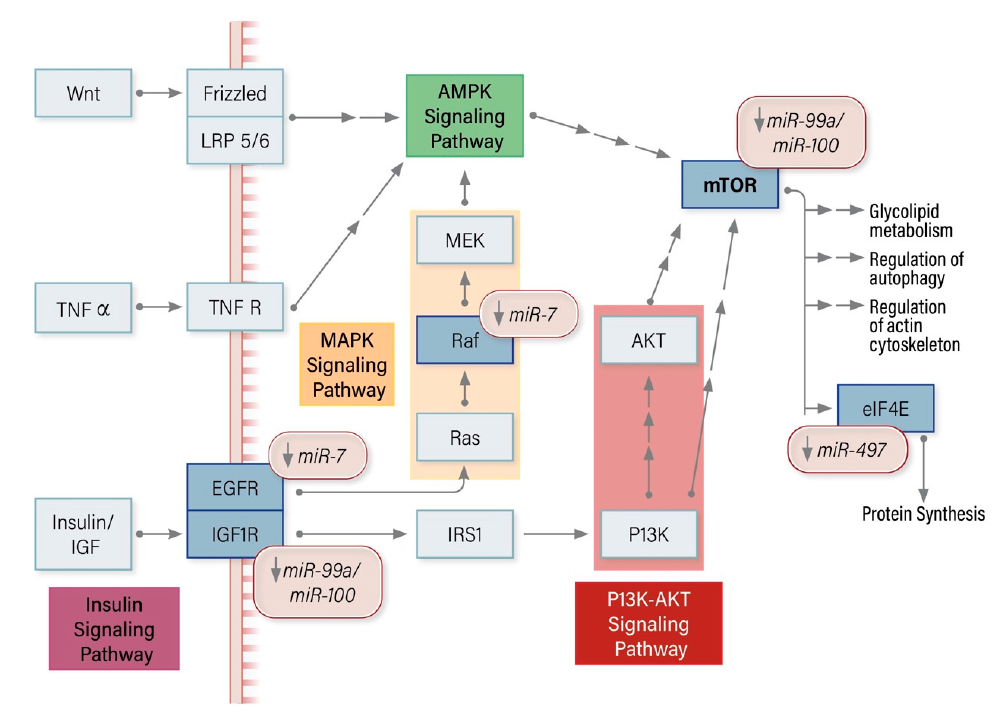
Figure 2. miRNA modulators of the mTOR signaling pathway in Adrenocortical Carcinoma.